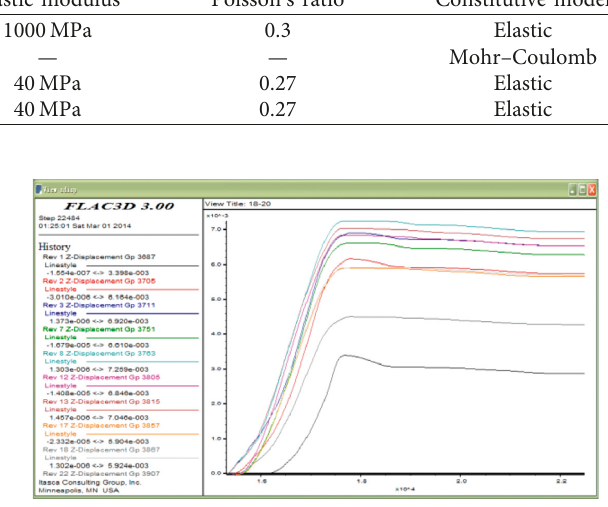
Figure 5: The vertical deformation for each history point of 18–20 type.